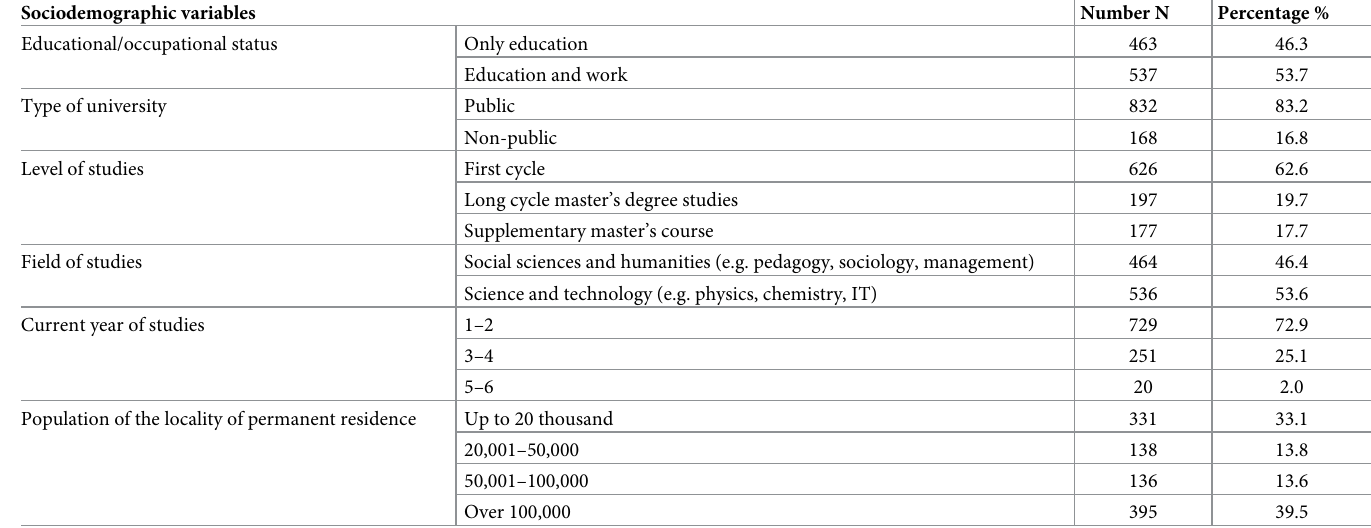
Table 1. Sociodemographic characteristics of the studied group (N =